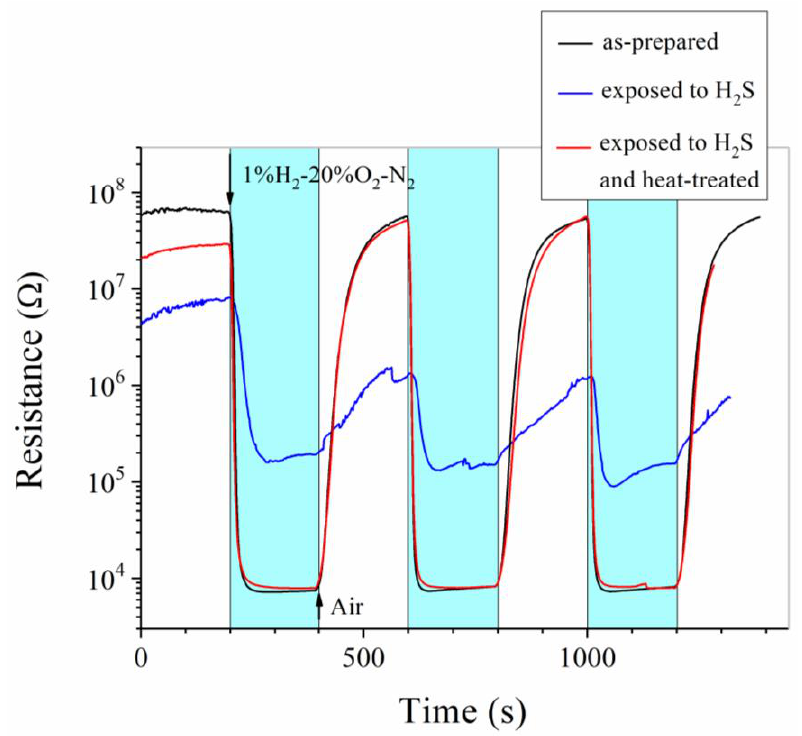
Figure 7. Room-temperature responses to 1% H 2 –20% O 2 –N 2 and recovery in air for a Pt–SnO 2 nanoceramic sample: as-prepared, being exposed to H 2 S, and being exposed to H 2 S and then being heat-treated, separately.